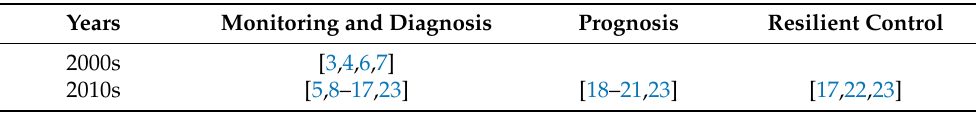
Table 1. Review papers on monitoring and diagnosis, prognosis, and resilient control for wind energy systems.